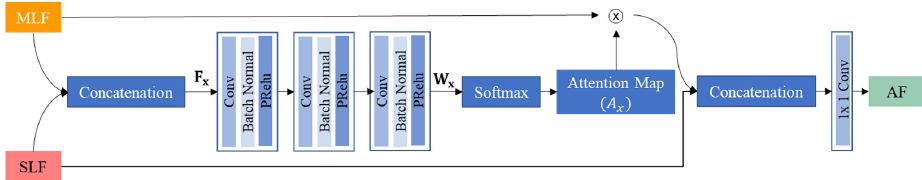
Figure 3. Block diagram of the DAF module.